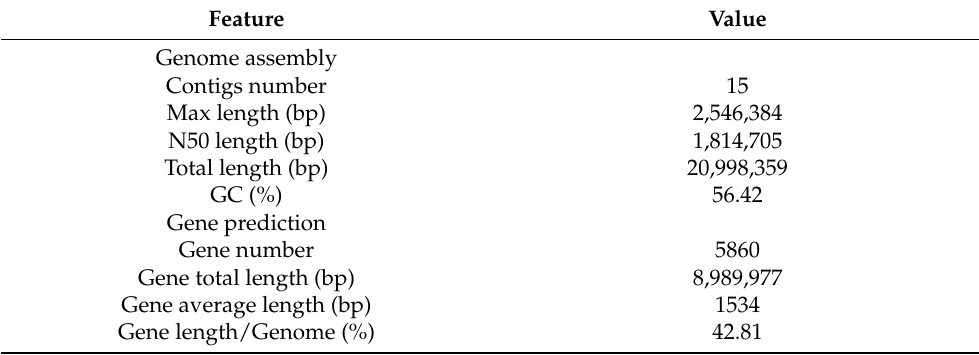
Table 1. T Statistics of N. aurantialba NX-20 genome assembly and gene